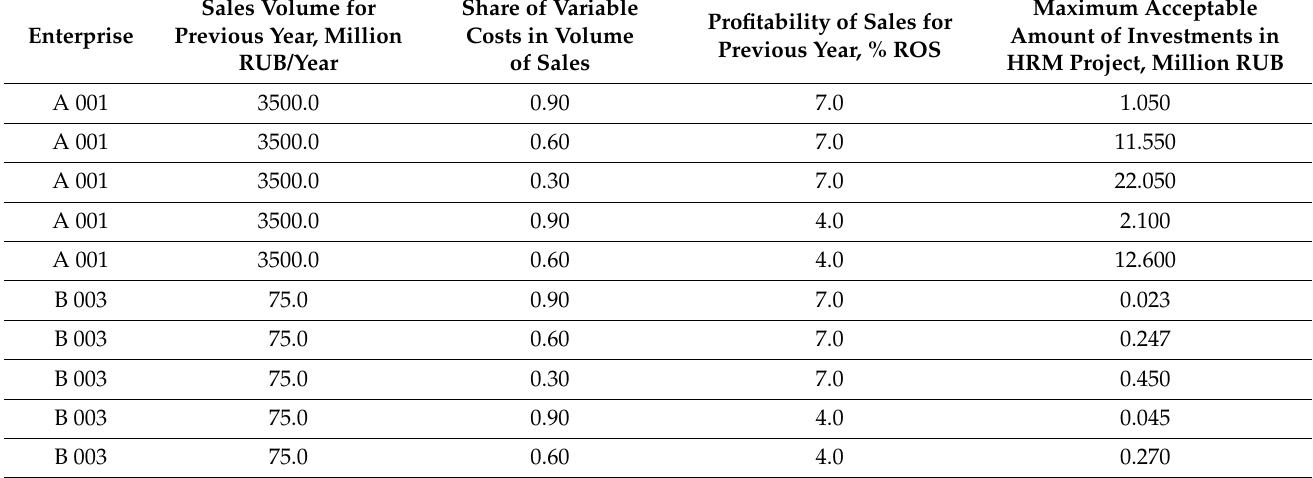
Table 2. Calculation of the maximum standard costs for the implementation of the organizational HR management (HRM) project with a planned increase in labor productivity and sales of products K pl by